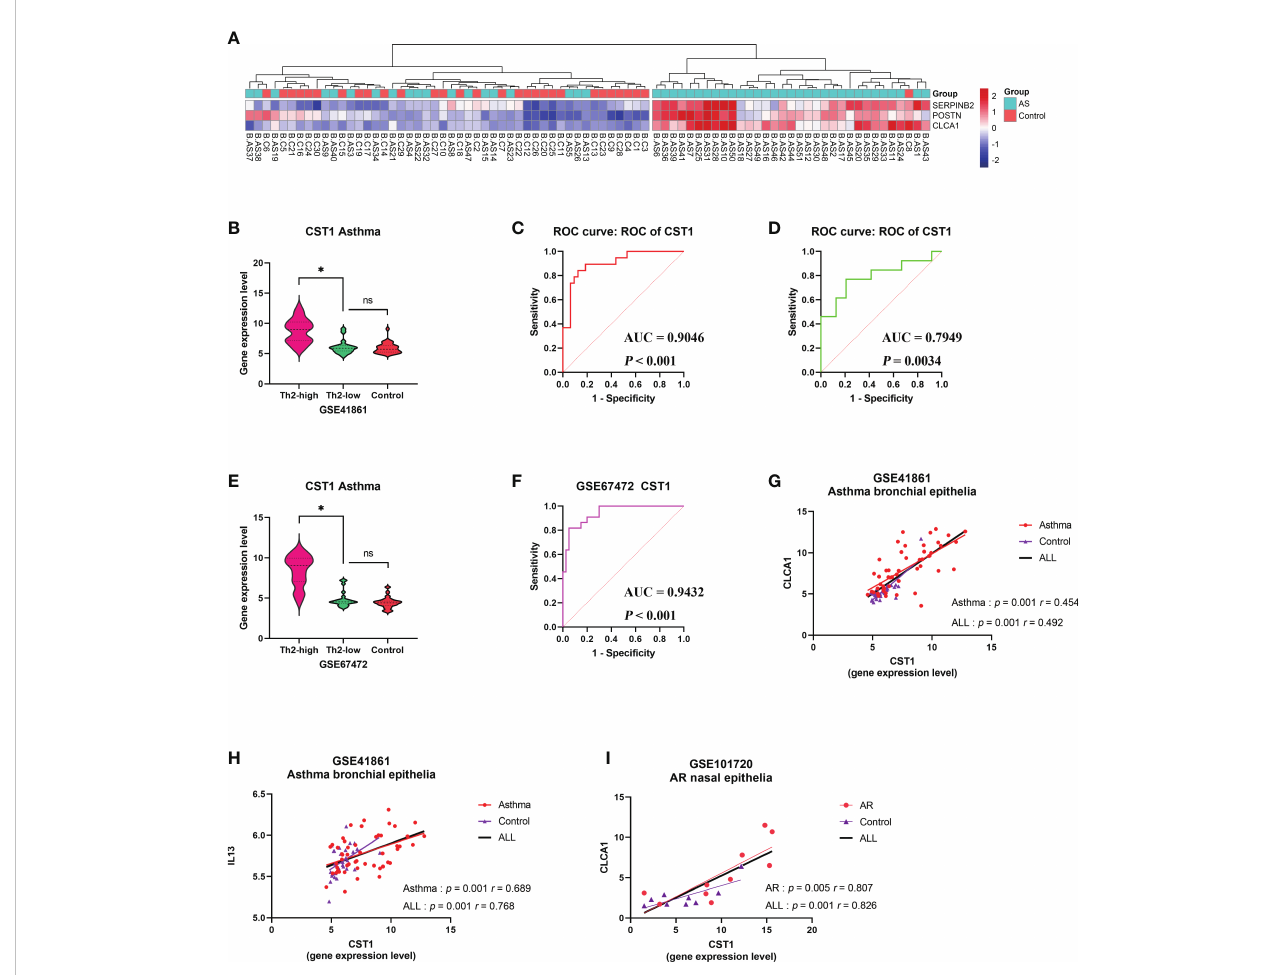
FIGURE 7 Correlation analysis between CST1 and Th2-high asthma. (A) Heatmap showing unsupervised hierarchical clustering of POSTN, CLCA1, and SERPINB2 expression levels in bronchial epithelium. Red represents a high expression level, and blue represents a low expression level. (B) Violin plots show the expression levels of CST1 in Th2-high asthma, Th2-low asthma, and controls in GSE41861. (C) ROC curves of CST1 expression levels in bronchial epithelium discriminating Th2-high asthma and Th2-low asthma in GSE41861. (D) ROC curves of CST1 expression levels in nasal epithelium discriminating Th2-high asthma and Th2-low asthma in GSE41861. (E) Violin plots show the expression levels of CST1 in Th2-high asthma, Th2-low asthma and controls in GSE67472. (F) ROC curves of CST1 expression levels in bronchial epithelium discriminating Th2-high asthma and Th2-low asthma in GSE67472. (G) Correlation analysis and scatter plot of CST1with CLCA1 expression levels in bronchial epithelium in GSE41861. (H) Correlation analysis and scatter plot of CST1 with IL13 expression levels in bronchial epithelium in GSE41861. (I) Correlation analysis and scatter plot of CST1 with CLCA1 expression levels in nasal epithelium in GSE101720. AS, Asthma; ns, no signi fi cance; * p < 0.05.